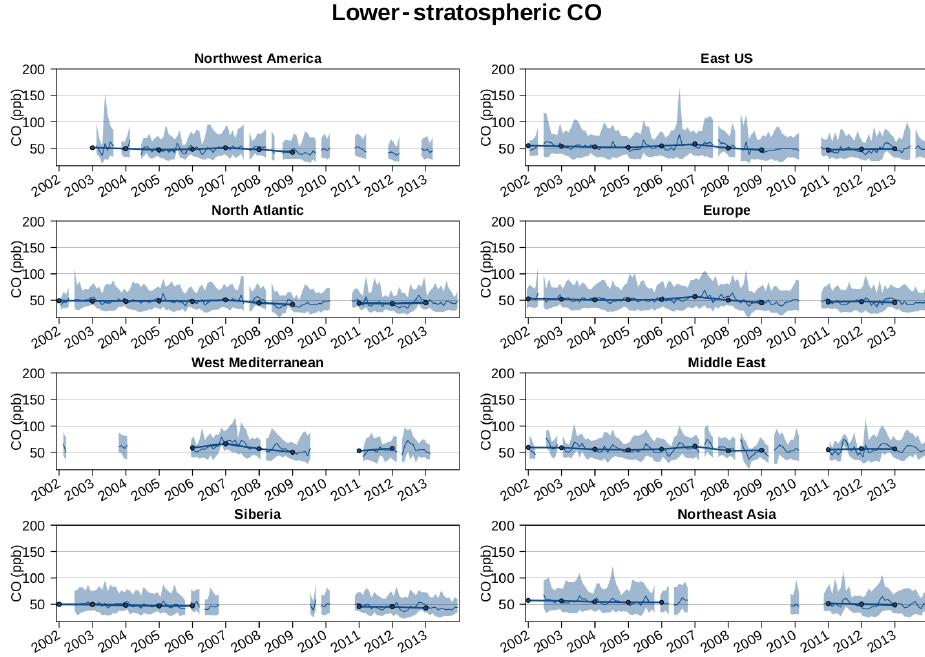
Figure B6. CO monthly mean values in the LS (thin curve). The interval from 5th and 95th percentiles is filled in blue. The yearly mean values are represented by the bold curve and the black